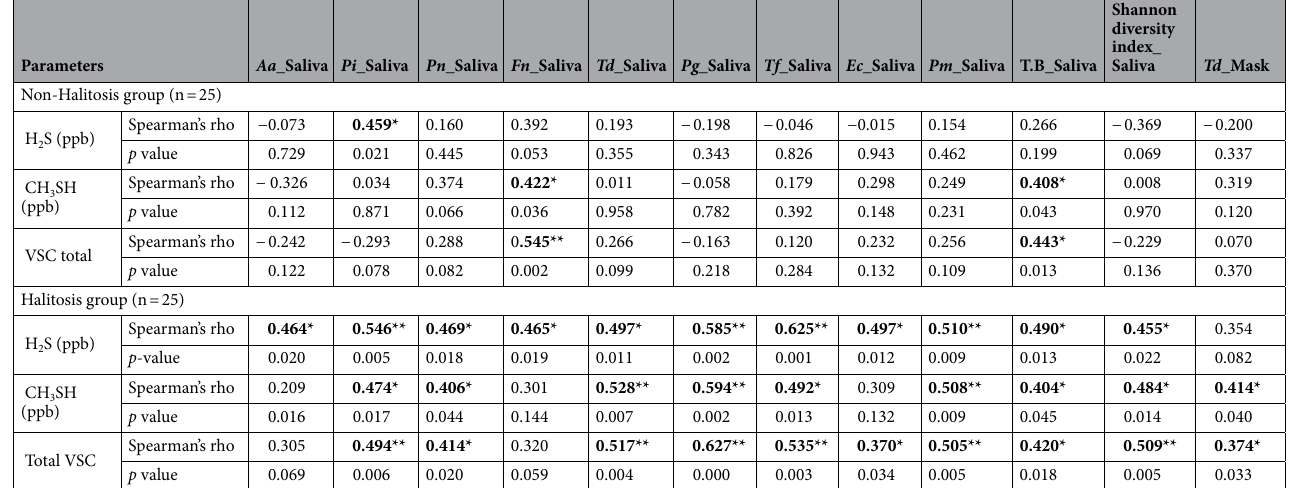
Table 4. Bacterial factors that increase VSC levels. The results were obtained via Spearman’s correlation analysis. P -value was considered as significant when p value < 0.05 (* p < 0.05, ** p < 0.01). The significant results are shown in bold. Aa: Aggregatibacter actinomycetemcomitans, Pi: Prevotella intermedia, Pn: Prevotella nigrescens, Fn: Fusobacterium nucleatum, Td: Treponema denticola, Pg: Porphyromonas gingivalis, Tf: Tannerella forsythia, Ec: Eikenella corrodens, Pm: Parvimonas micra, T.B: total bacterial DNA copy numbers, _Saliva: DNA copy number of each bacterium detected in Saliva, _Mask: DNA copy number of each bacterium detected on the inner surface of the mask, VSC: volatile sulfur compound